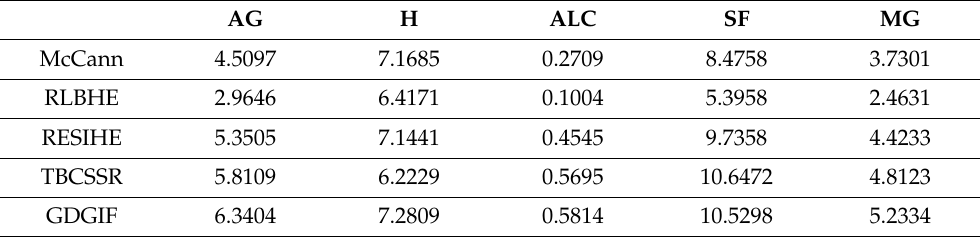
Table 5. The average metric data of eight methods on 69 X-ray images. AG H